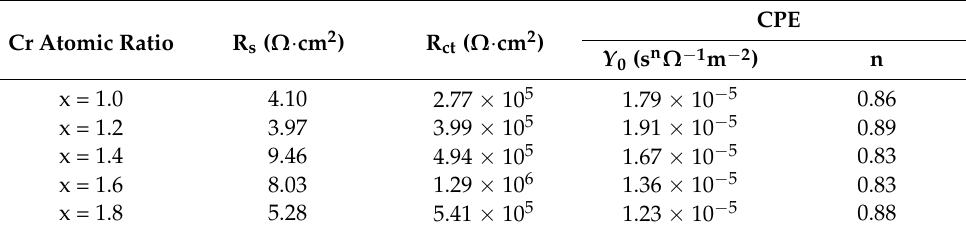
Figure 7. Nyquist plots ( a ) and Bode plots ( b ) of the electrode interface for AlSi 0.5 Cr x Co 0.2 Ni (x = 1.0, 1.2, 1.4, 1.6, and 1.8) high entropy alloys, respectively; the insert in Figure 7a is the electrical equivalent circuits fitting the EIS experimental data (3.5 wt.% NaCl solution). Table 5. Equivalent circuit elements fitting results for EIS data corresponding to AlSi 0.5 Cr x Co 0.2 Ni (x = 1.0, 1.2, 1.4, 1.6, and 1.8) high entropy alloys.